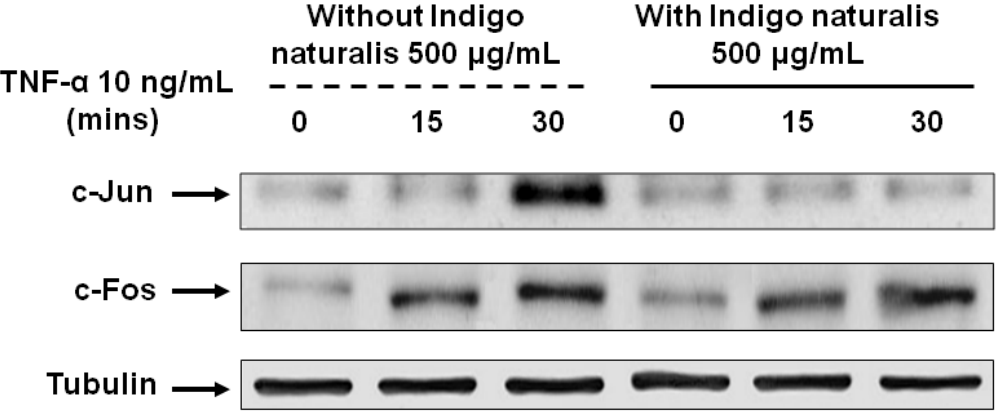
HUVECs were treated with TNF- α (10 ng/mL) for the indicated time in the presence or absence of indigo naturalis extract (500 μ g/mL) pretreatment for 18 h. The total cell lysates were then prepared and the expression levels of c-Jun and c-Fos were detected by Western blot analysis. Tubulin was used as loading control. The data were representatives of three separate experiments with similar